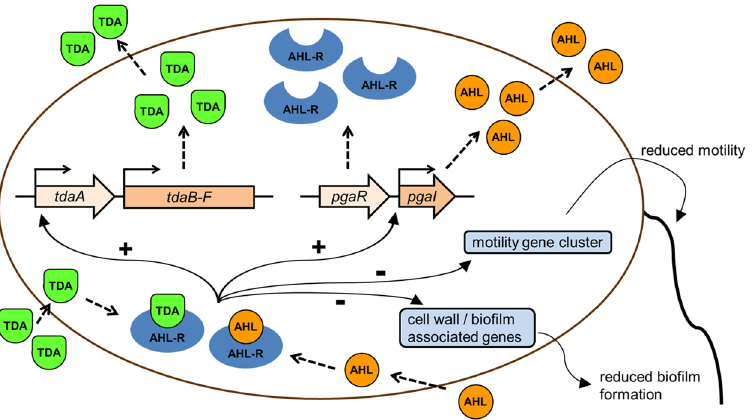
Figure 4. Proposed scheme of quorum sensing signaling in cells of P. inhibens . The pgaR gene is encoding for the AHL regulator (AHL-R) and pgaI for the AHL synthase. AHL as well as TDA molecules interact with the AHL regulator to regulate differential gene expression. QS up-regulates expression of the TDA gene cluster tdaB-F and of tdaA , an essential transcriptional regulator for the TDA gene cluster, and thus, increases TDA production. Expression of the pgaI gene is significantly down-regulated in the pgaR mutant compared to WT (Extended Data Table 1), thus upregulated by QS. Therefore, TDA and AHL signaling results in a double positive feedback loop. Genes associated with motility or surface attachment are down-regulated by QS and, consequently, swimming speed and biofilm formation are